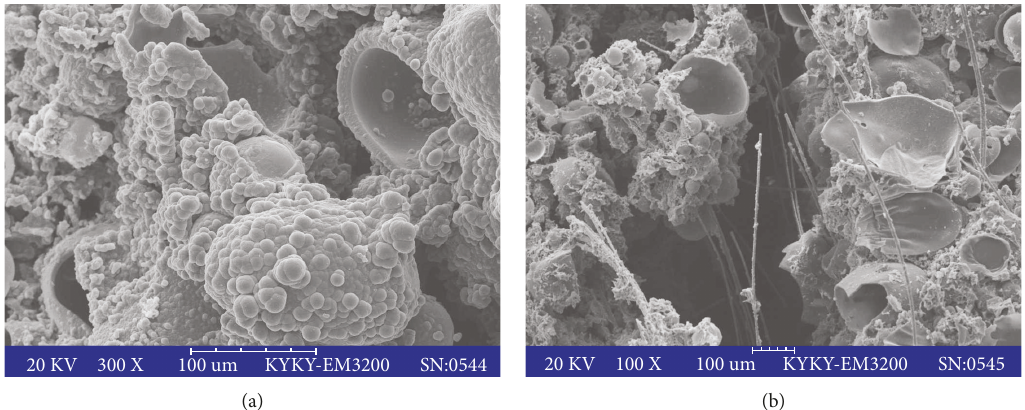
Figure 12: Carbon deposited image of the resin matrix ablation material ’ s carbonized layer: (a) 300 times magni fi ed image and (b) 100 times magni fi ed image.